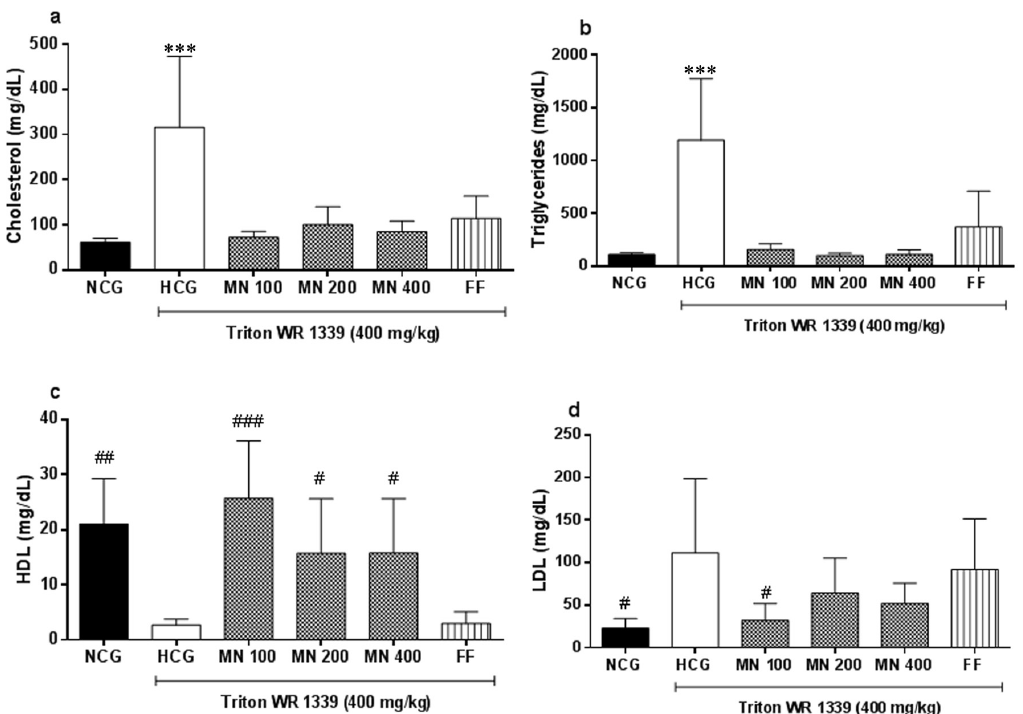
Figure 2 - Effect of Morus nigra infusion extracts (MN) or fenofibrate (FF) on serum total cholesterol ( a ), triglycerides ( b ), HDL ( c ) and LDL ( d ) levels in Triton WR-1339-induced hyperlipemic rats (HCG). Values are expressed as means ± SEM ( n =6-8). *** p <0.001 HCG compared with other groups and ### p <0.001 or # p <0.05 compared with HCG